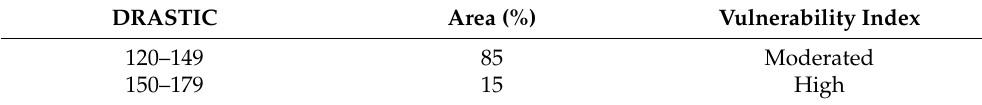
Figure 2. Spatial distribution of the vulnerability index obtained by the DRASTIC-LU model, ( a ) continuous variation, and ( b ) classes of the vulnerability index . Table 3. The DRASTIC-LU model in the OPP obtained the vulnerability index.